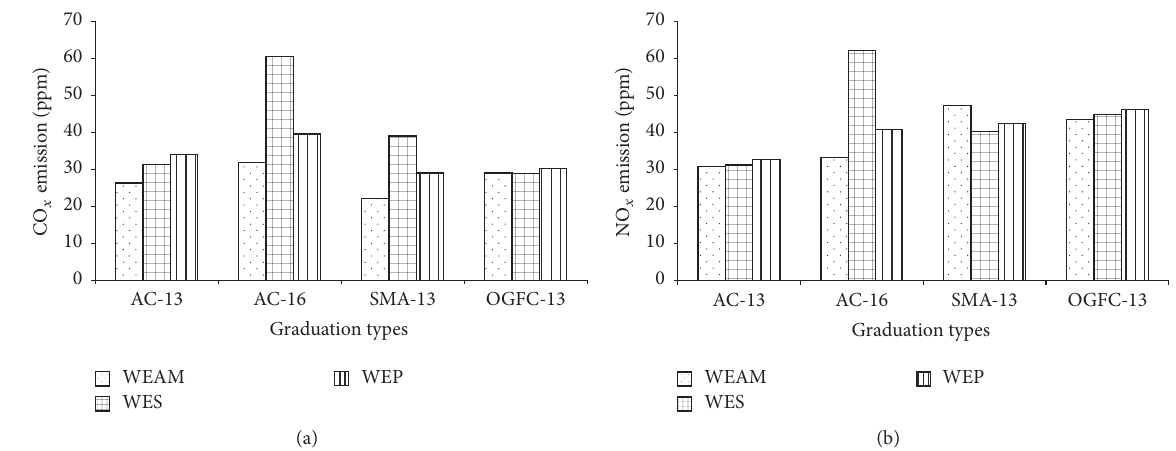
Figure 8: Different modifiers and gradations and the emission reduction rate.